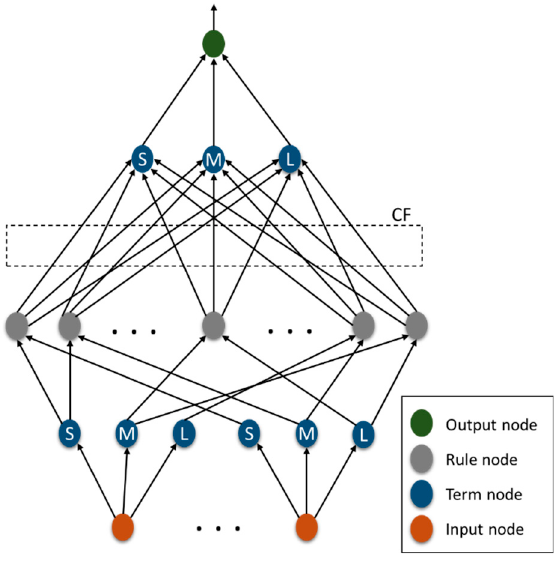
Figure 2. The structure of the Neuro-Fuzzy model from the HyFIS architecture.